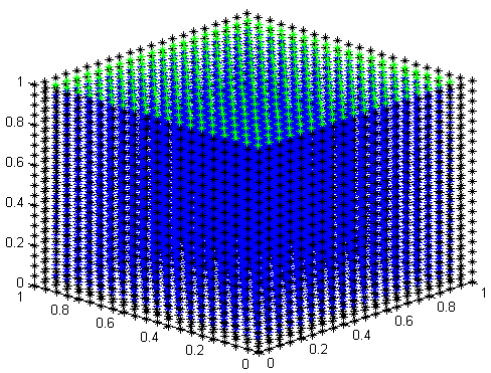
Figure 6. Second regular cloud of points for the 3D examples (Cloud 4).